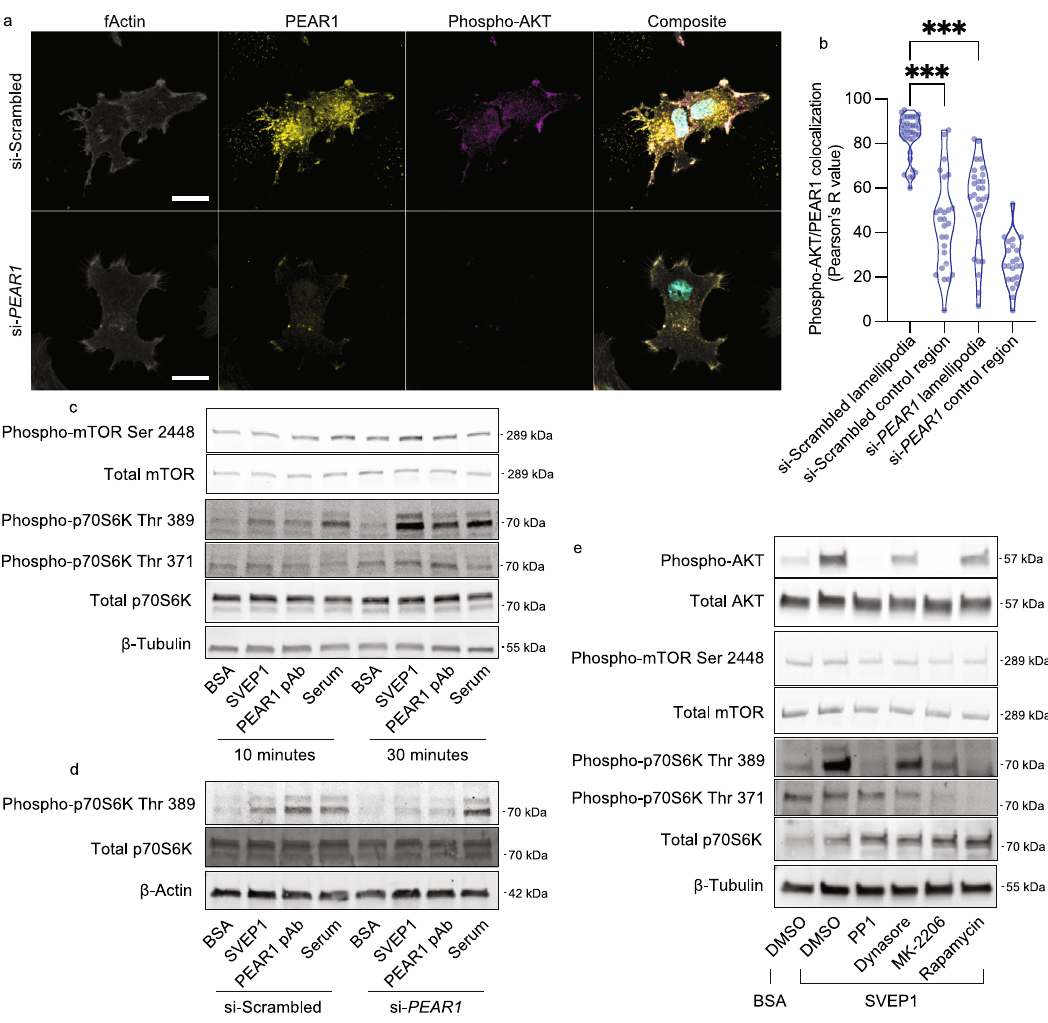
Fig.4|mTORsignalingisactivatedbySVEP1-inducedPEAR1signaling.a Images of hCASMCs pre-treated with scrambled siRNA or anti- PEAR1 siRNA seeded on immobilized SVEP1 for 60min. Scale bar=20 μ m. Composite image includes DAPI (teal). b Quanti fi cationofPEAR1andpAKTcolocalizationin a ,asdeterminedbythe Pearson correlation coef fi cient. Lamellipodia were identi fi ed as bundles of fActin onthe peripheryofcells.Cellularregionsnotcontaininglamellipodiawereused as controlregions. N =36,26,28,and22regions.*** P =1.5×10 − 15 or P =2.8×10 − 11 from ANOVAwithposthocunpaired,two-sided t -test. c HUVECsexposedtoimmobilized